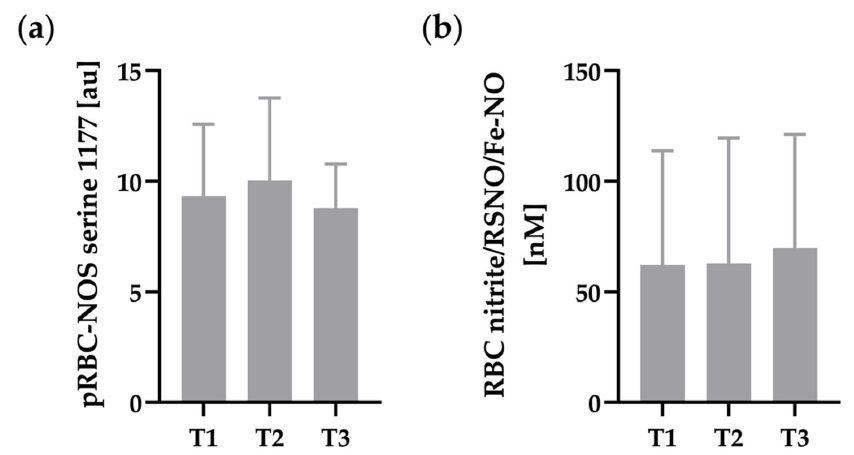
Figure 3. ( a ) Phosphorylation of RBC ‐ NOS at serine 1177 residue and ( b ) corresponding RBC ni ‐ trite/RSNP/Fe ‐ NO concentration were not affected by hypoxia. ( a ) n = 16 and ( b ) n =